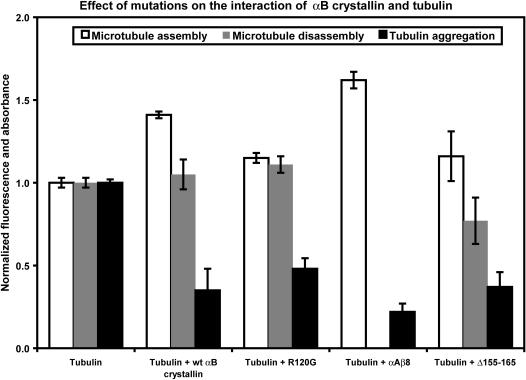
Effect of mutations in three αB crystallin interactive domains on microtubule assembly, disassembly, and tubulin aggregation.The DAPI fluorescence of assembled microtubules, disassembled tubulin, and tubulin aggregates in the absence of αB crystallin mutants was normalized to 1.0. In the presence of wt αB crystallin, microtubule assembly increased, microtubule disassembly was unchanged, and tubulin aggregation decreased. In the presence of the R120G mutant, which contains a mutation of the Arg-120 residue in the 113FISREFHR
120 interactive sequence of αB crystallin, microtubule assembly decreased and microtubule disassembly and tubulin aggregation were similar to wt αB crystallin. In the presences of the αAβ8 mutant, in which the β8 sequence 131LTITSSLS138 of αB crystallin was replaced with the β8 sequence of αA crystallin 127SALSCLSS134, microtubule assembly increased, microtubule disassembly decreased, and tubulin aggregation was unchanged relative to wt αB crystallin. In the presence of the C-terminal deletion mutant Δ155–165, microtubule assembly and disassembly were lower and tubulin aggregation was unchanged relative to wt αB crystallin. Mutagenesis of sequences in αB crystallin corresponding to the αB crystallin peptides that altered tubulin-microtubule dynamics confirmed the effects of the αB crystallin peptides on microtubule assembly/disassembly and tubulin aggregation.